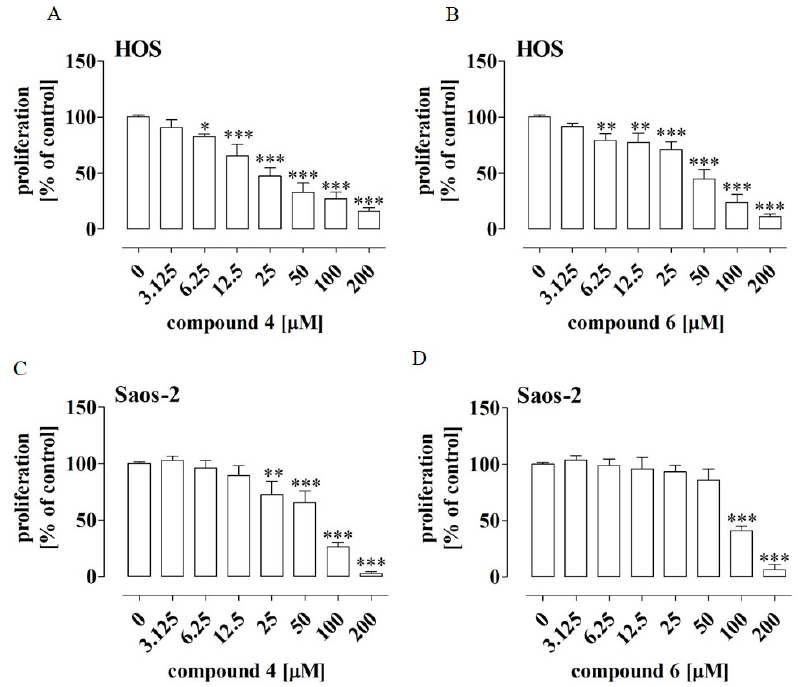
Figure 1. Effect of compounds 4 and 6 on proliferation of HOS ( A , B ) and Saos-2 ( C , D ) cells. The cells were treated with the compounds at the indicated concentrations for 96 h. The cell proliferation was determined by means of anMTT assay. The results are mean values ± SD of at least three independent experiments. Statistically significant differences: *—at p < 0.05, **—at p < 0.01, and ***—at p < 0.001 in comparison to the untreated cells (one-way ANOVA followed by Dunnett’s post-hoc test).